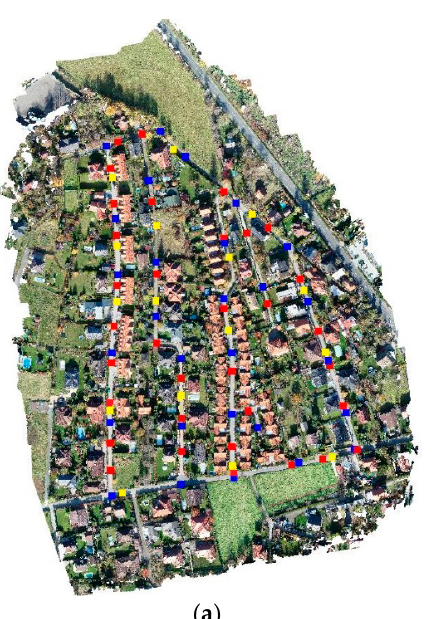
Figure 4. Placement of the ground control points (ground control points (GCPs), blue) and checkpoints (horizontal— black/yellow; vertical—red) for both sites – Urban ( a ), Rural ( b ).